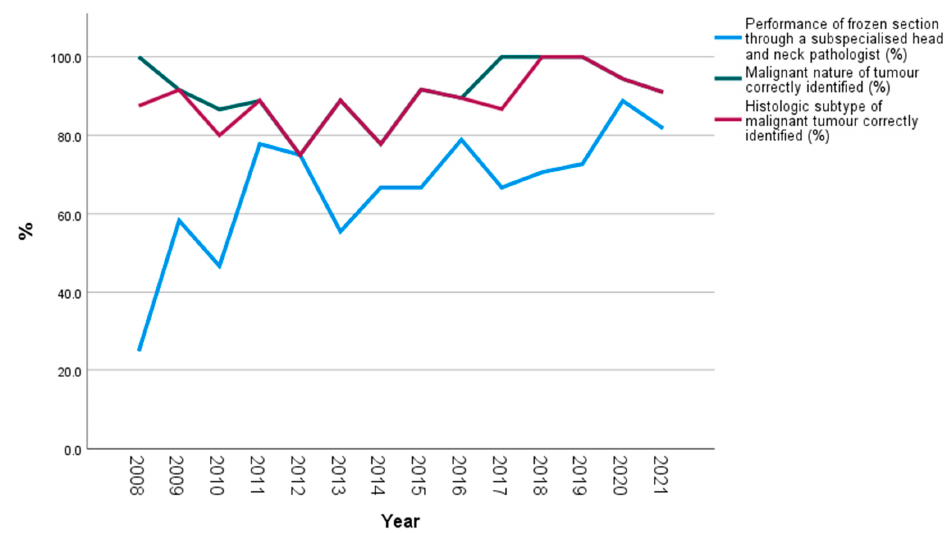
Figure 1. Performance of frozen section by a subspecialised head and neck pathologist, and performance of frozen section concerning correct identification of malignant tumours and their histologic subtypes over the years (the number of examined cases per year is given next to each year in the x axis of the